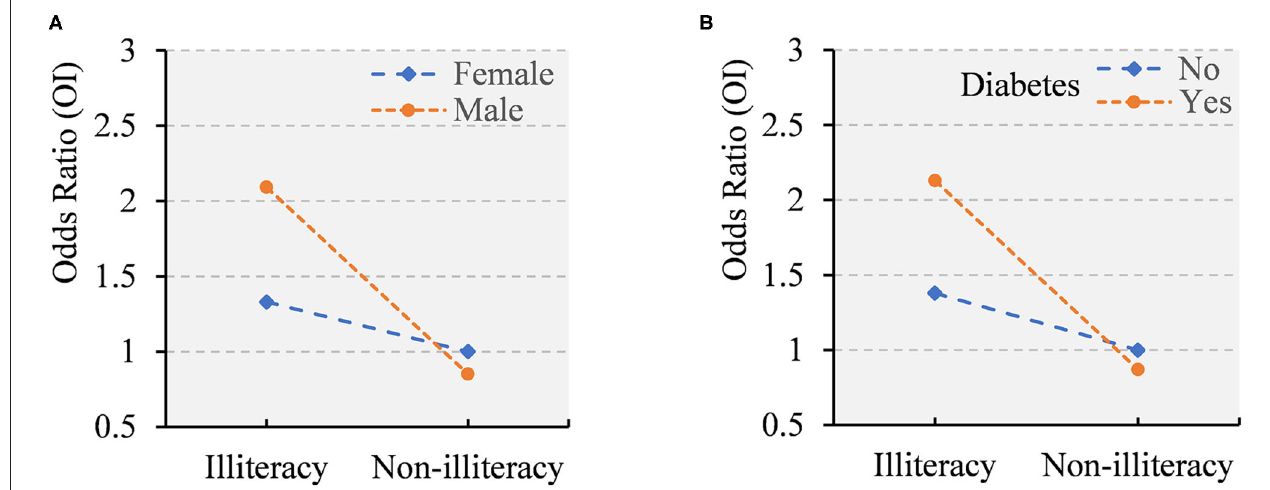
FIGURE 2 | Interactions of educational level with sex (A) and diabetes (B) on olfactory impairment (OI) ( p for both interactions <